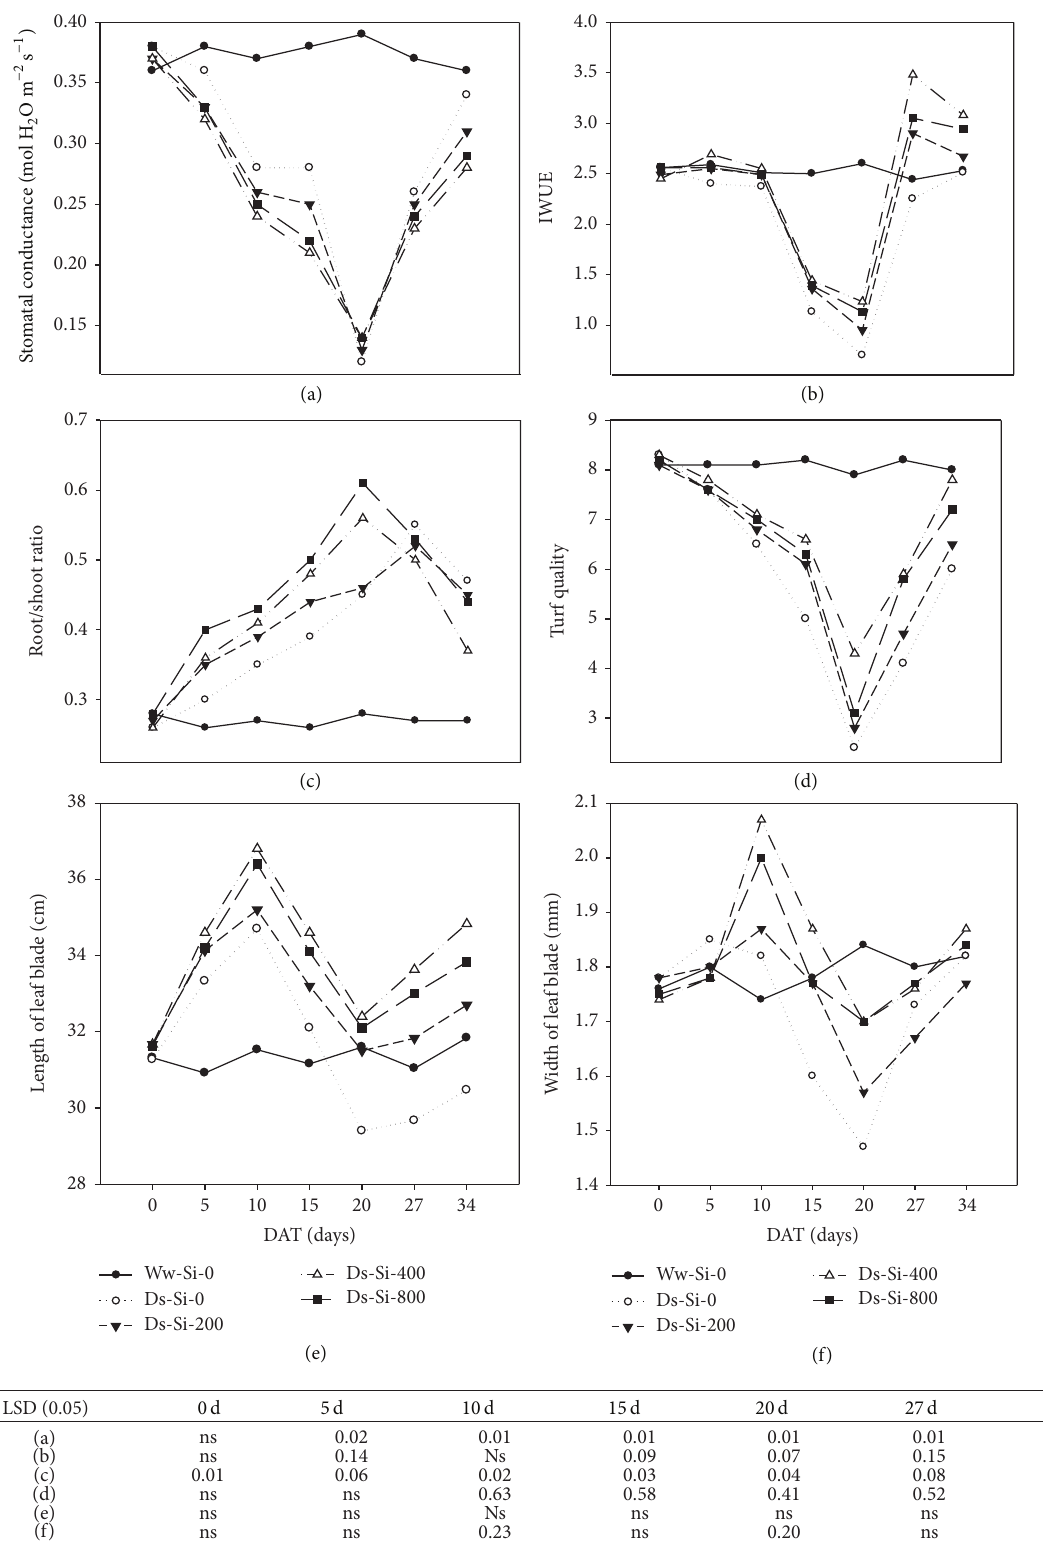
Figure 2: Influence of silicon application on (a) stomatal conductance, (b) IWUE, (c) root/shoot ratio, (d) turf quality, (e) leaf blade length, and (f) leaf blade width of Kentucky bluegrass under drought stress. ns: nonsignificant; DAT: days after treatment; Ww: well watered; Ds: drought stress; Si-0, Si-200, Si-400, and Si-800 means Si application at 0, 200, 400, and 800 mg L −1 , respectively. From 𝑡 = 0–20 days: drought stress period, after 20 days: recovery